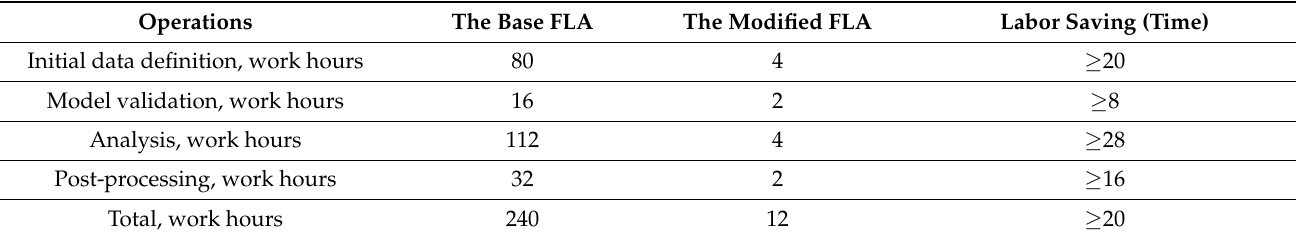
Table 5. Analysis of labor intensiveness of strength analysis of regional aircraft airframe structure.